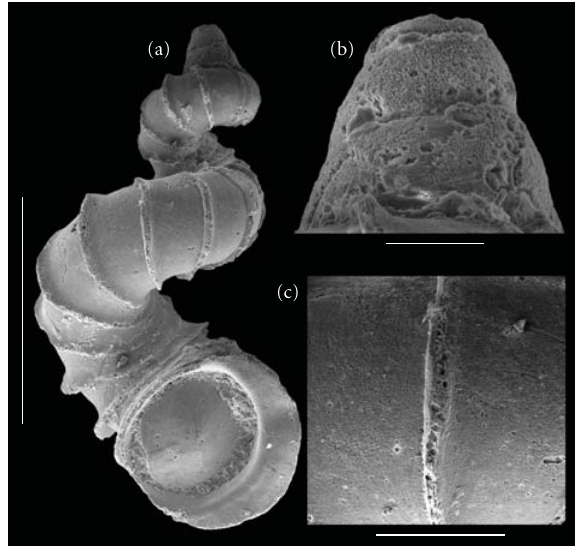
Figure 4: (a–c) Cycloscala echinaticosta (MNRJ 17.165); (a) ventral view, (b) protoconch view, and (c) detail of teleoconch ornamenta- tion. Scale bars: (a) 1 mm, (b) 100 μ m, and (c) 200 μ m. with 8 to 9 scalloped axial costae completely encircling teleo- conch (Figure 4(a)). Axial interspaces smooth (Figure 4(c)). Aperture circular (Figure 4(a)). Outer and inner lip thin (Figure